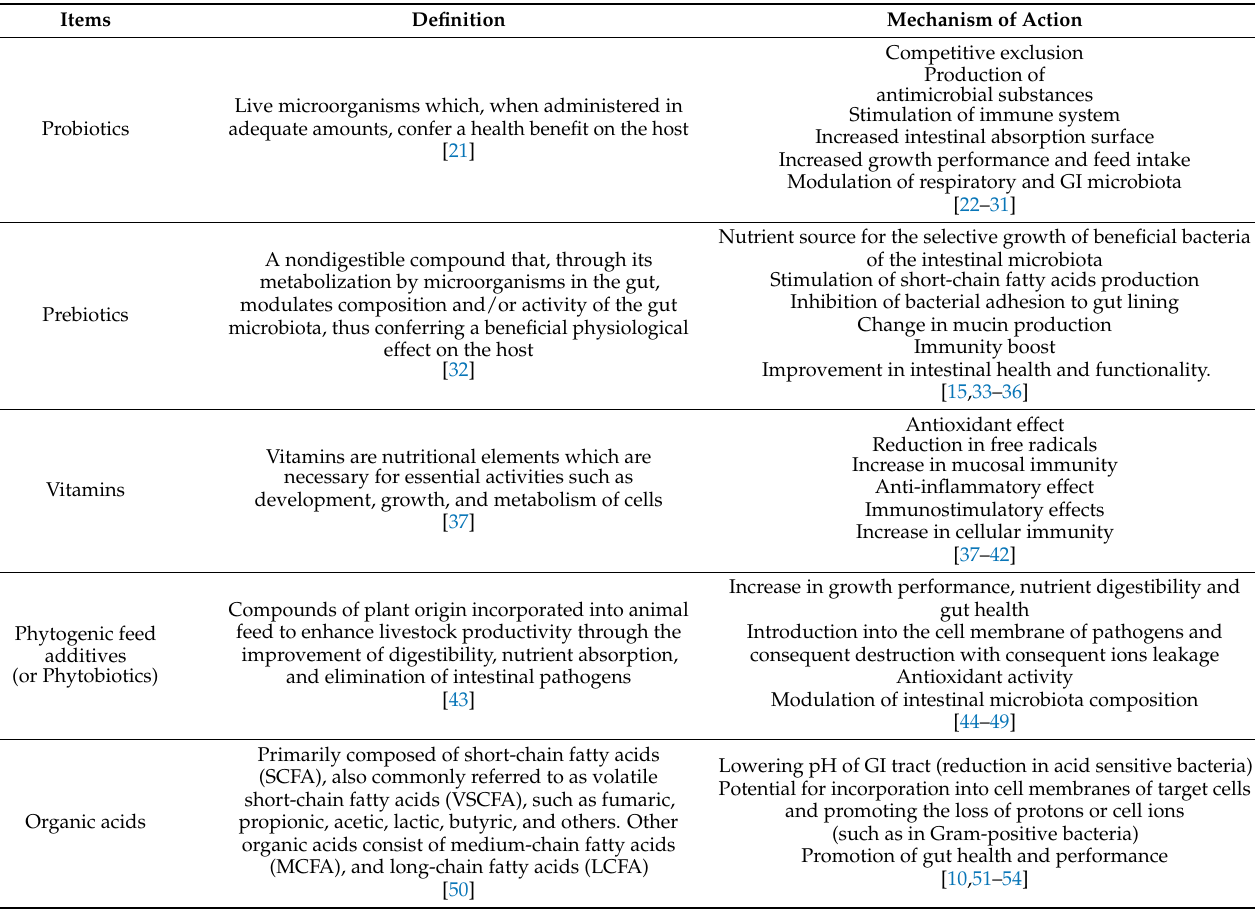
Table 2. Description of products for the regulation of the intestinal bacteria population in poultry and their principal